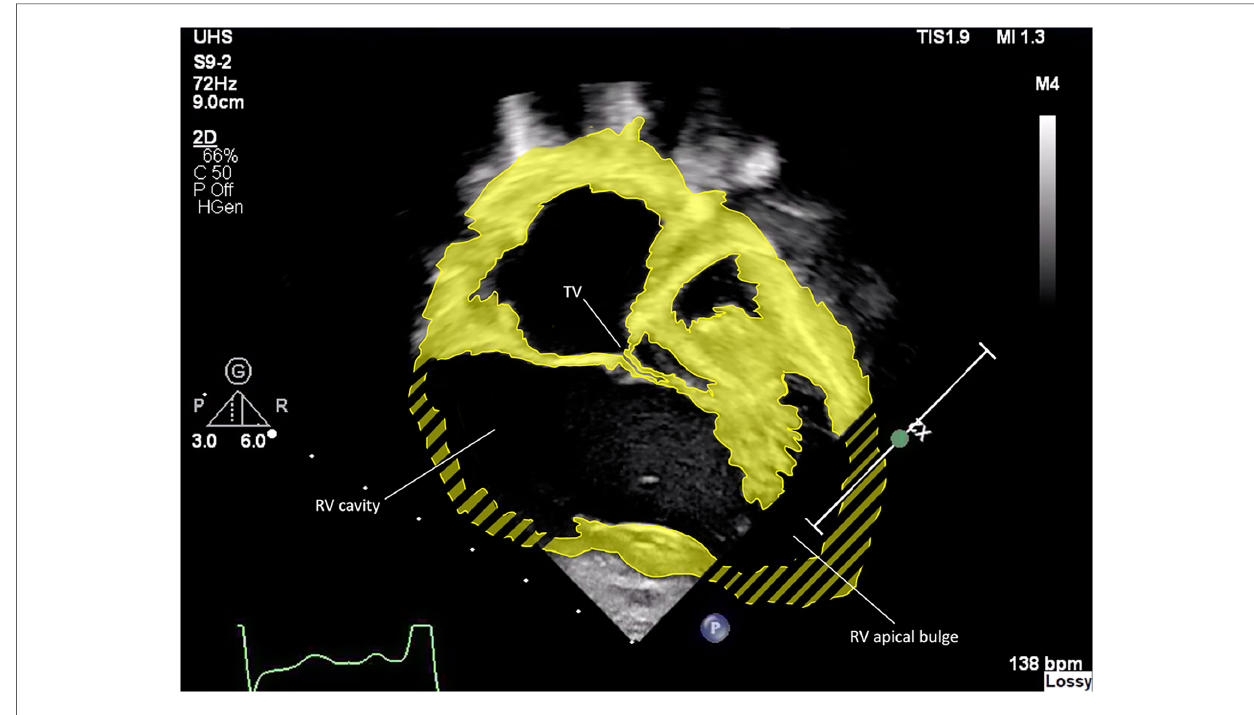
FIGURE 7 Enhanced 2D echocardiographic subcostal view. Note the RV apical bulge encircling the hypoplastic